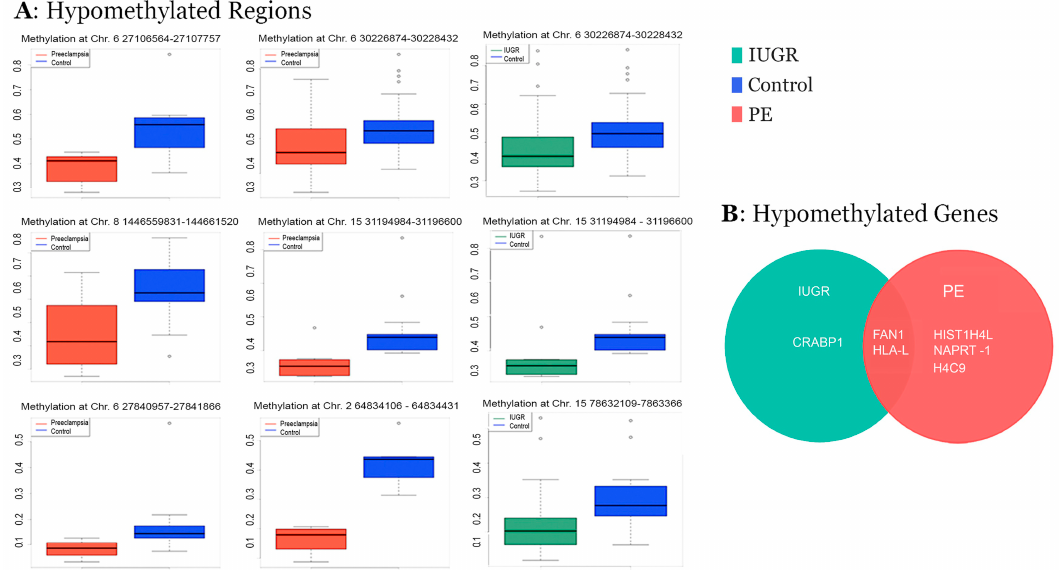
Figure 3. Shared areas of hypomethylation at key regulatory regions in both PE and IUGR placental tissues. Bar plots indicating methylation beta-values at signi fi cantly hypomethylated regions (FDR > 40) in IUGR and PE samples compared with control ( A ). Venn diagram of each hypomethylated gene promoter region associated with PE and IUGR ( B ).